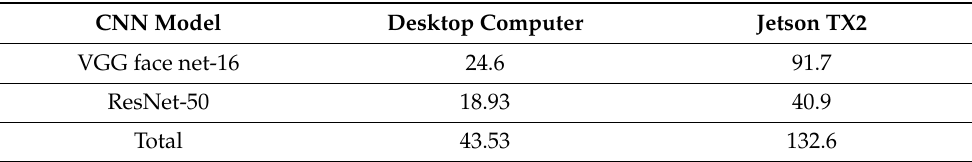
Table 21. Comparison of desktop computer and Jetson TX2 processing times by ResNet-50 and VGG face net-16 (unit: